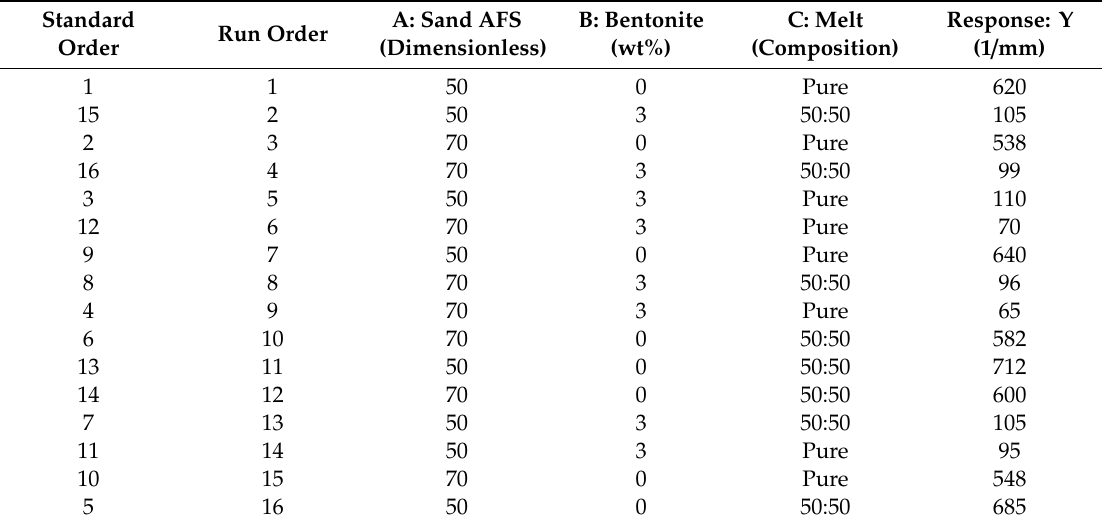
Table 5. Experimental